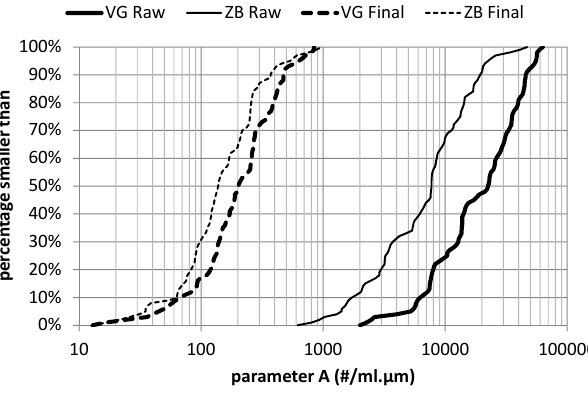
Figure 5. The cumulative distribution of model parameter A .